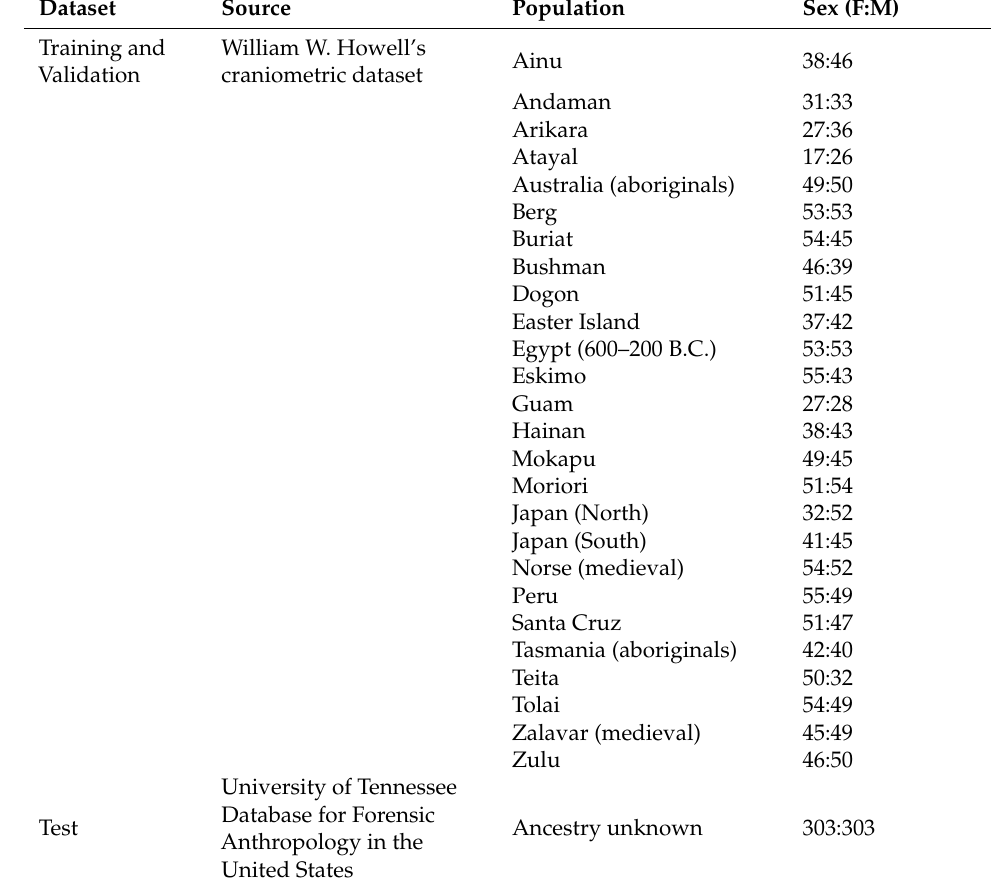
Table 2. Details of the sample used. Source, population (if known), and sex attribution are reported. Sample sizes refer to the datasets after the transformations operated for the scopes of the current